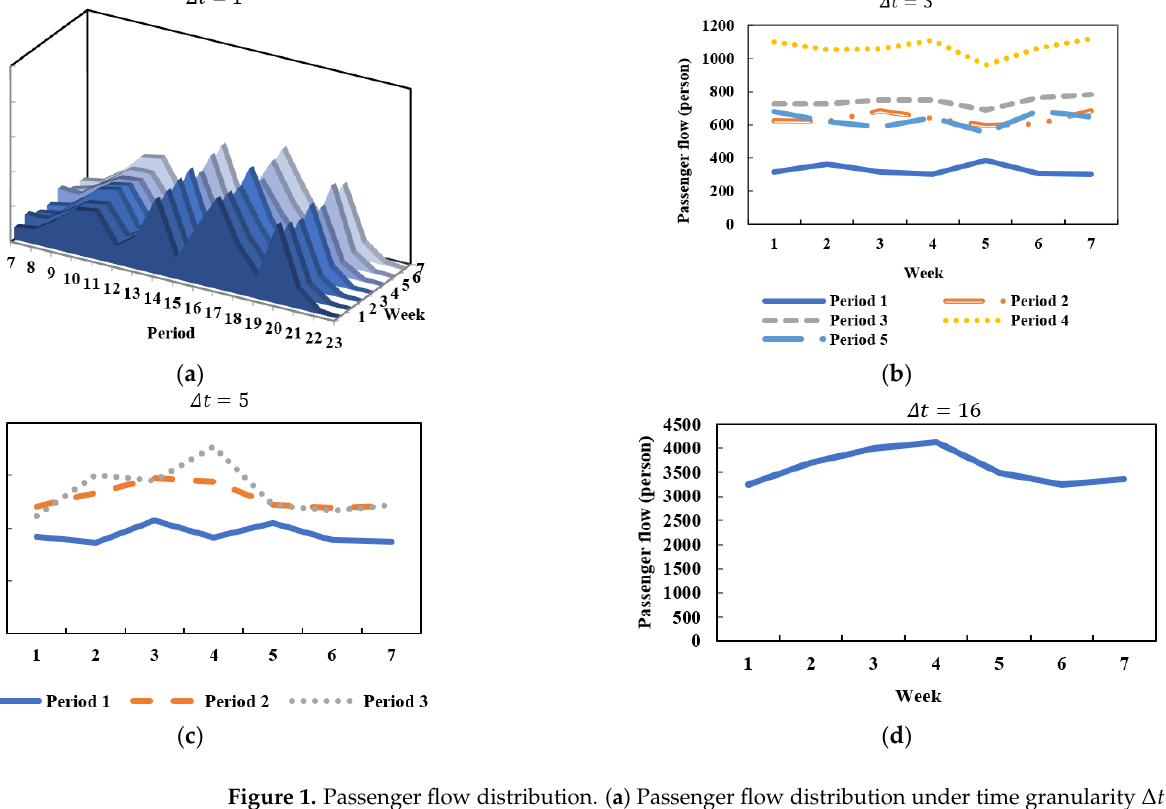
Figure 1. Passenger flow distribution. ( a ) Passenger flow distribution under time granularity ∆ t = 1, ( b ) Passenger flow distribution under time granularity ∆ t = 3, ( c ) Passenger flow distribution under time granularity ∆ t = 5, ( d ) Passenger flow distribution under time granularity ∆ t =